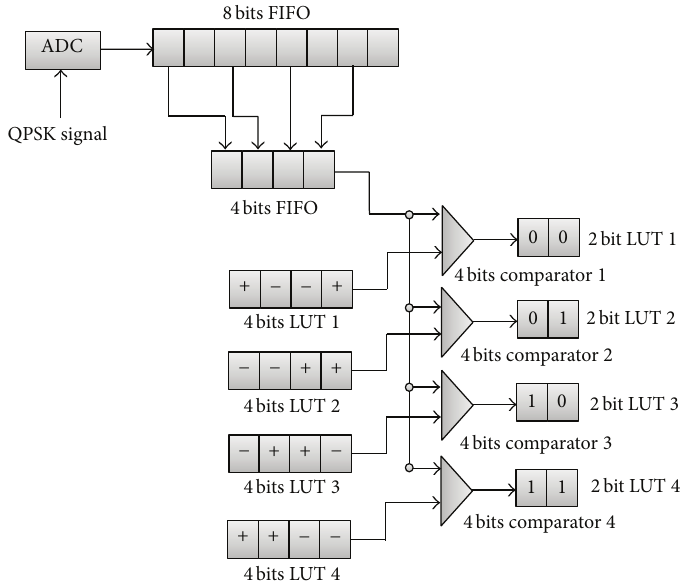
Figure 1: Block diagram for the proposed 8S-QPSK demodulator.